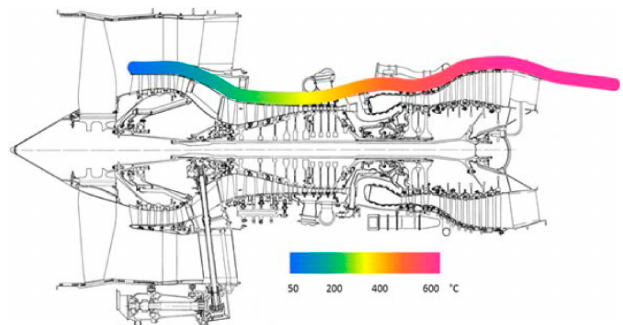
Figure 22. Typical casing temperature profile along an aeroengine with high bypass ratio [155].